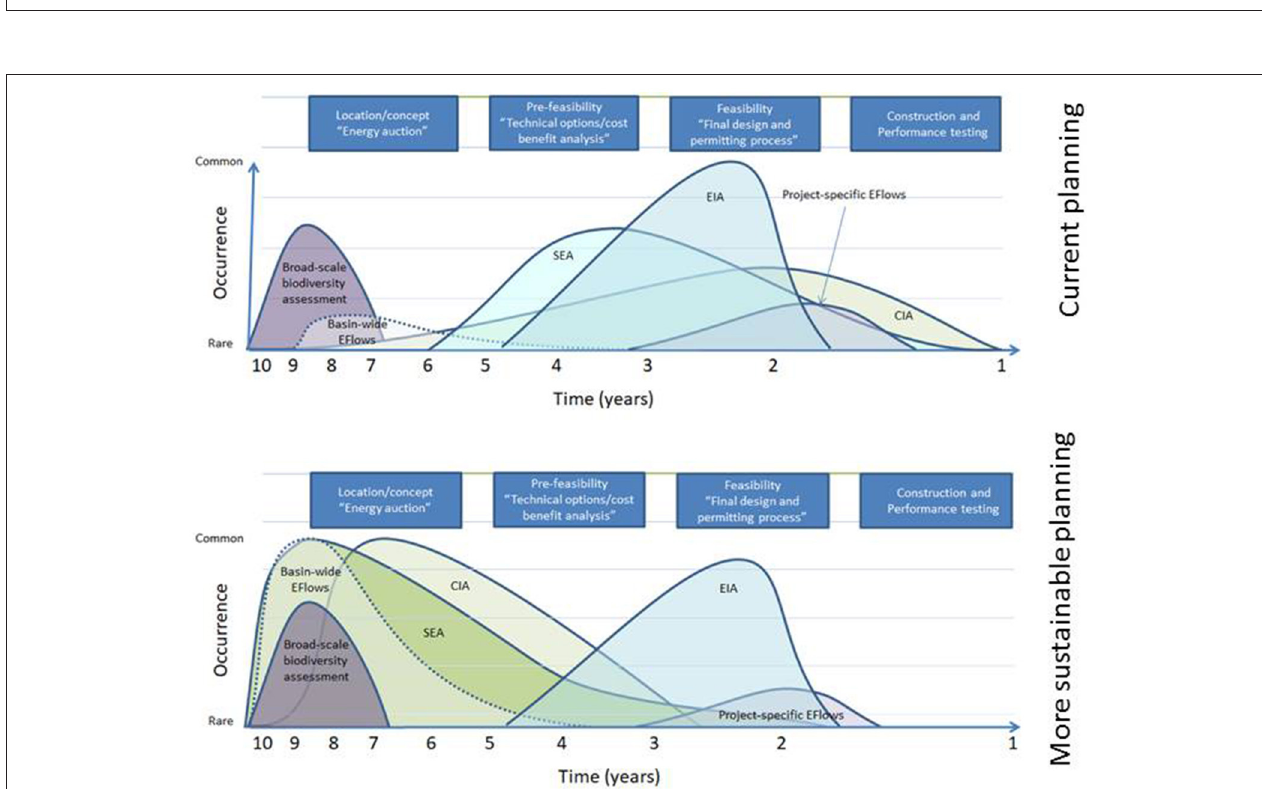
FIGURE 2 | Present and suggested future timing of the various conservation and impact assessments for new dams.